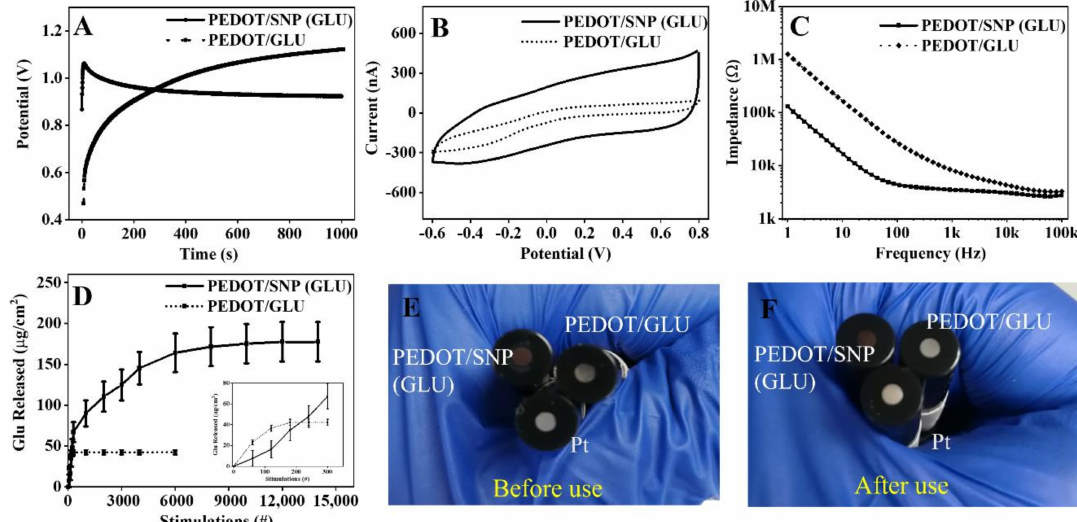
Figure 2. ( A – D ) Chronopotentiometry coating, CV scan, EIS and release profile comparison between PEDOT/SNP(GLU) and PEDOT/GLU. Insect in panel D shows release data from the first 300 stimulations for better visualization. ( E , F ) Optical micrographs of Pt, PEDOT/SNP(GLU), and PEDOT/GLU coated Pt macroelectrodes (2 mm diameter) before and after 1000 stimulation